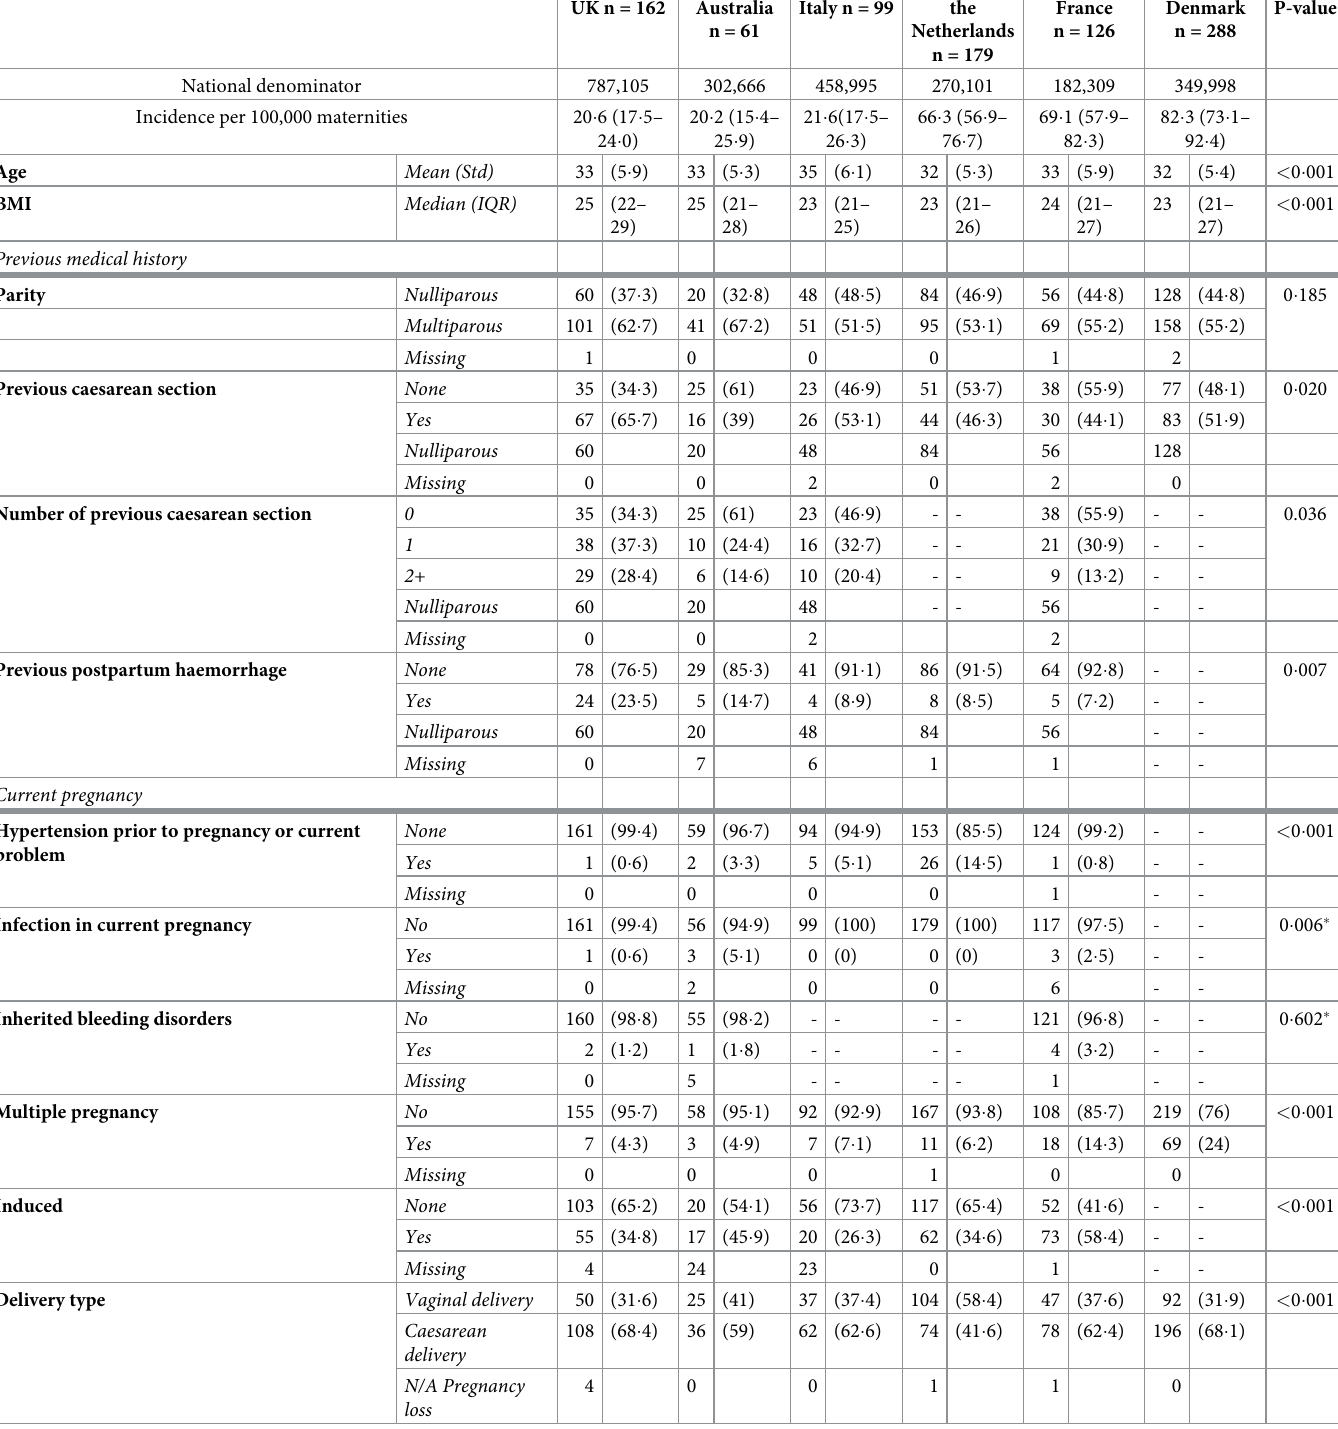
Table 2. Sociodemographic, previous medical history and current pregnancy information in women undergoing massive transfusion for major obstetric